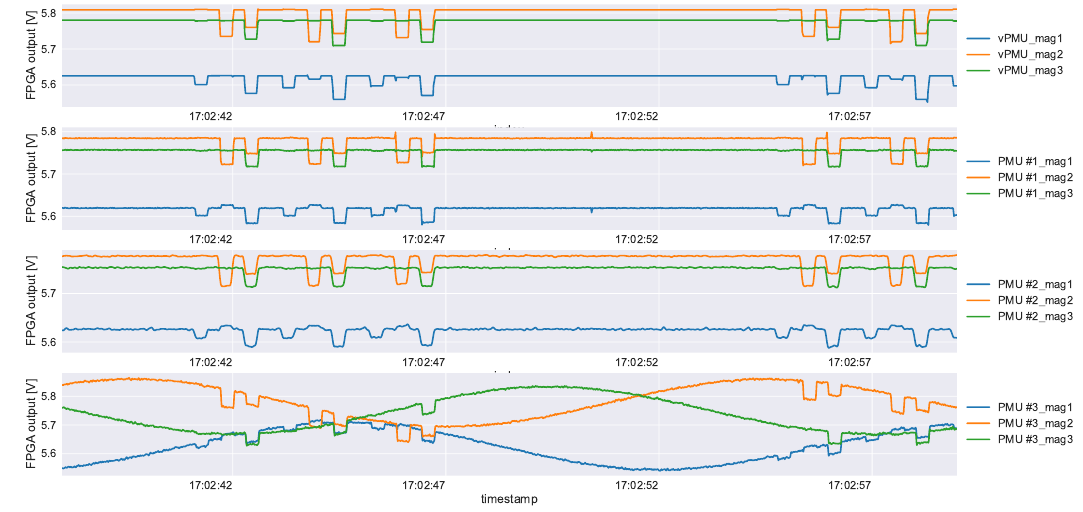
Figure 11. Comparison of measurements of three real PMUs and vPMU under a 50 Ω impedance